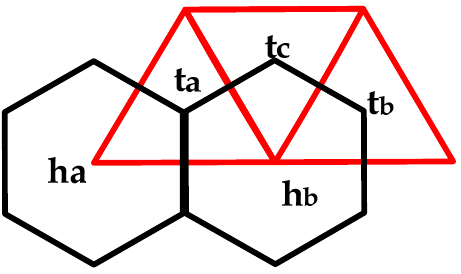
Figure 21. Correspondence between hexagonal grids and triangular grids.